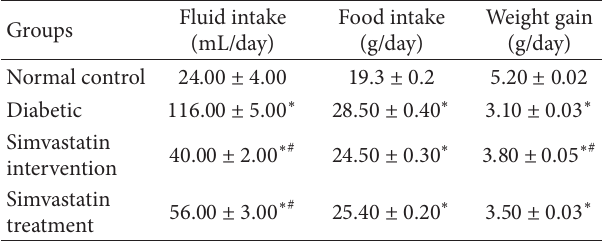
Table 1: Administration of simvastatin in fluid and food intake and body weight of rats in the different experimental